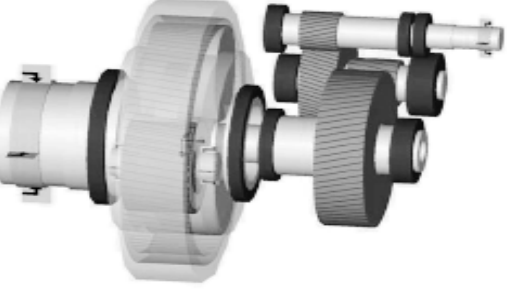
Figure 1. Structure of a gearbox for a wind